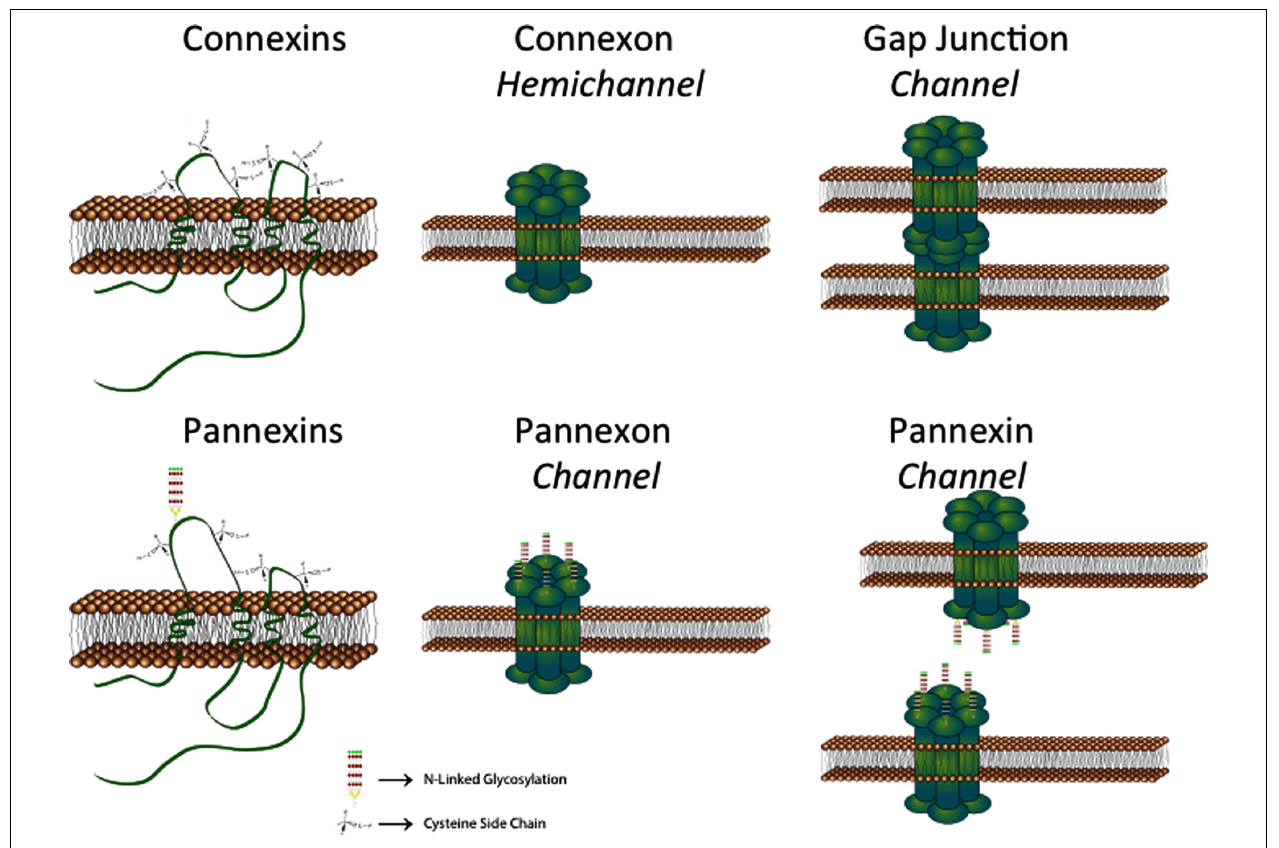
FIGURE 1 | Schematic showing that connexins can from both hemichannels and gap junction channels. In contrast, pannexins normally form channels equivalent to hemichannels. See text for details (provided by Stephen Bond, Ph.D.,